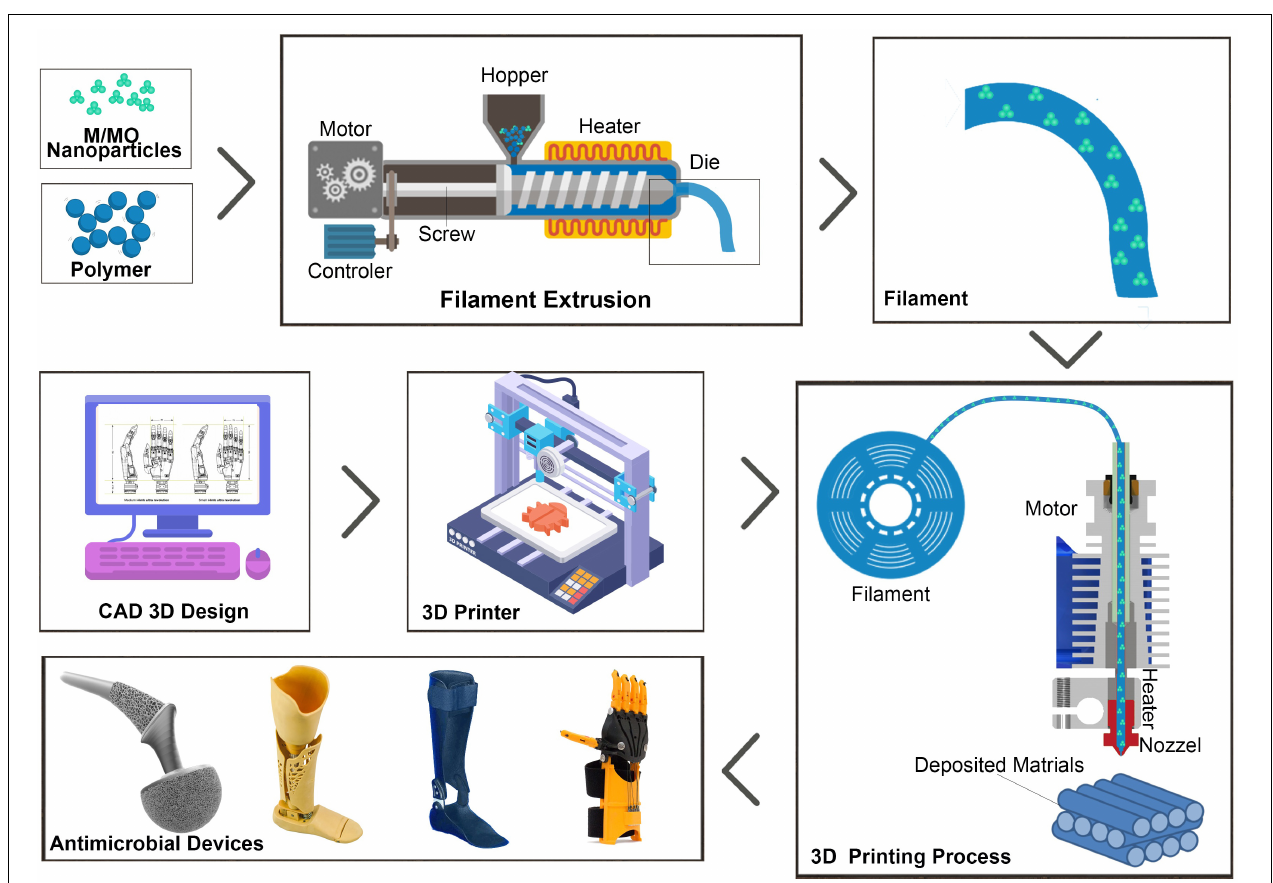
FIGURE 1 | Schematic illustration of 3D printing of M/MO incorporated thermoplastic nanocomposites using FDM process. Composite filaments can be made by extruding mixture of the M/MO nanoparticles with the thermoplastics. Then filaments are heat-melted and extruded from a nozzle and allowed to solidify in a printing bed. Pre-programmed computer aided design (CAD) model is used to control the printing